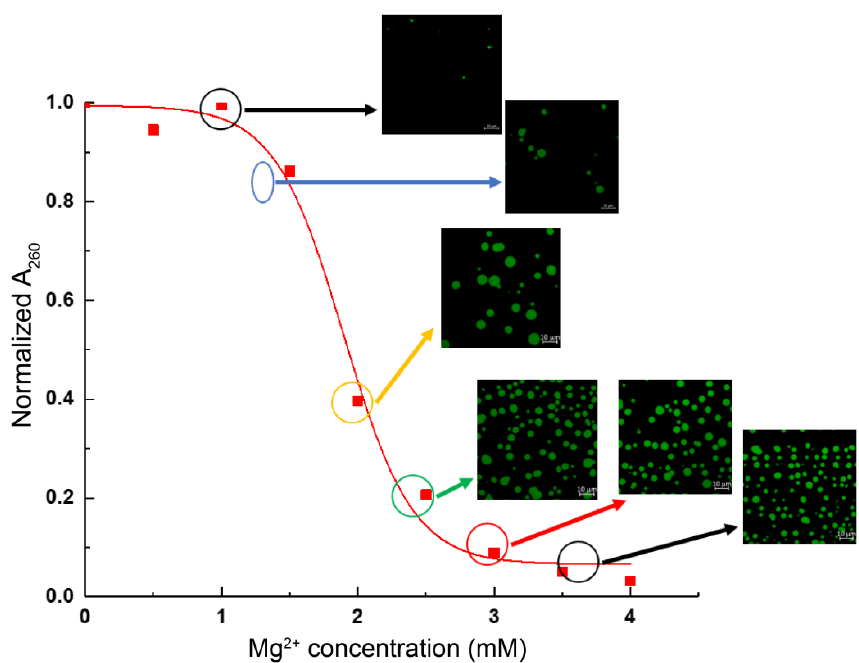
Figure 6. Precipitation assay curve and confocal fluorescence microscopy characterization of nucleosome arrays as a function of Mg 2+ concentration. DyeCycle was used to stain the DNA of the nucleosome arrays. The KCl concentrations in the buffers are 75 mM.